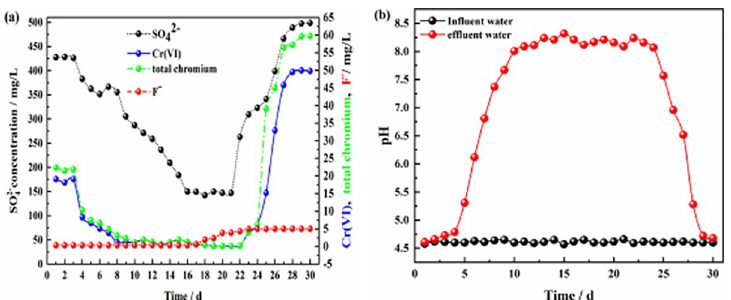
Fig 10. Effluent of dynamic column #5. (a) Effluent concentration of each pollutant ion; (b) pH values of influent and effluent water.